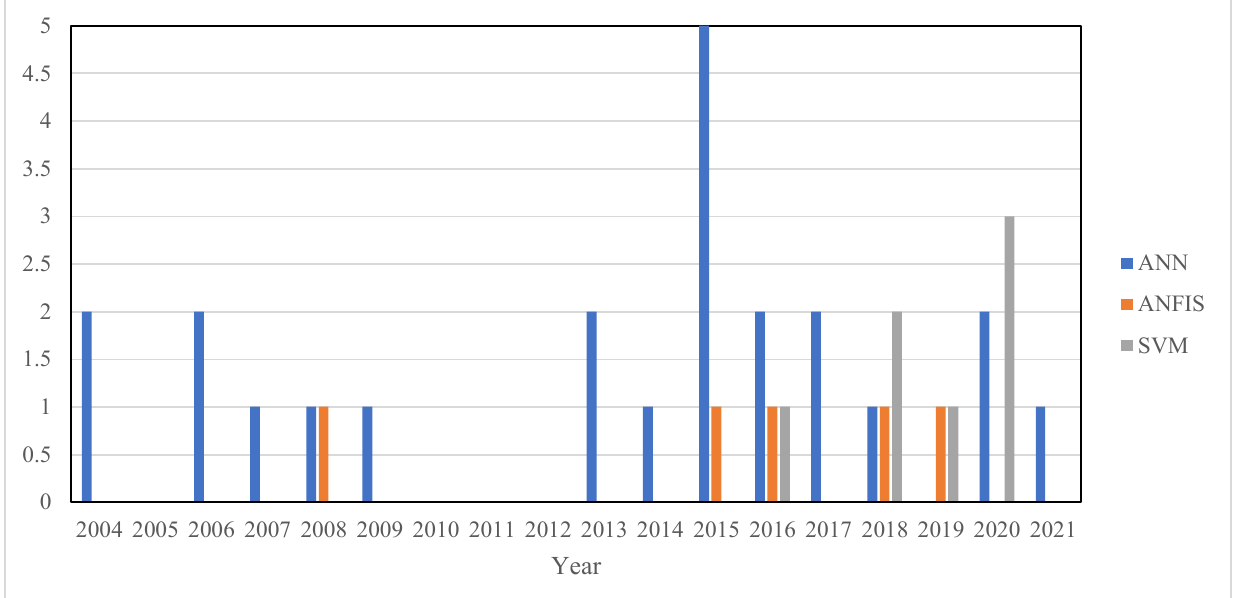
Figure 3. Usage frequency of AI-based RFFA methods during 2004–2021.